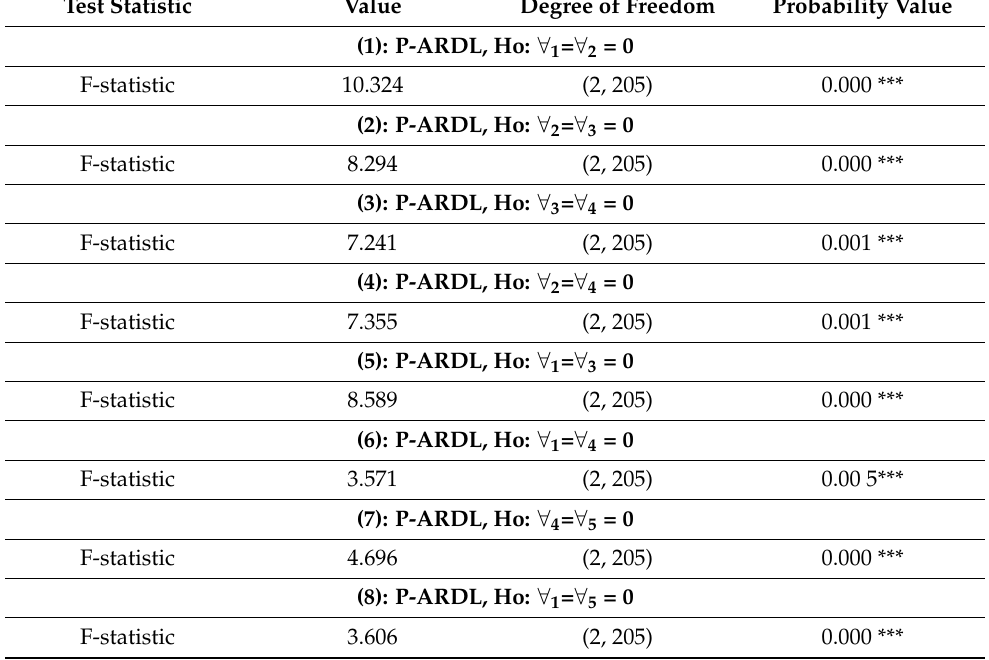
Table 9. Short-run causality